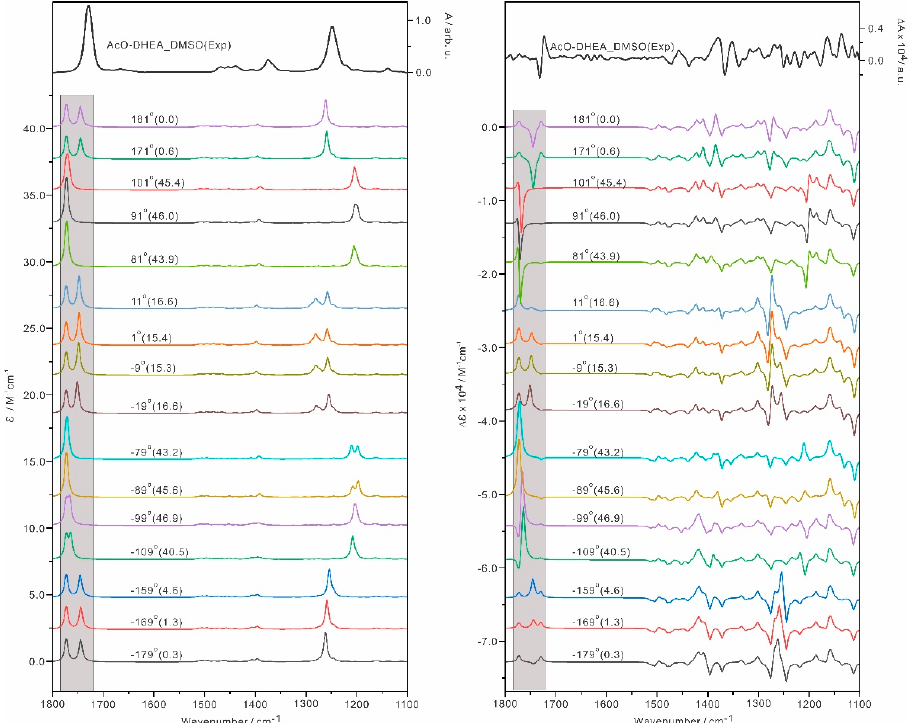
Figure 8. Simulated IR and VCD spectra of AcO − DHEA at several dihedral angle (C21 − O2 − C49 − C51) values along the PES (Figure S11) at the B3LYP − D3BJ/def2 − TZVPD/PCM(DMSO) level at 298 K. The relative energies in kJ mol − 1 are listed in the brackets.